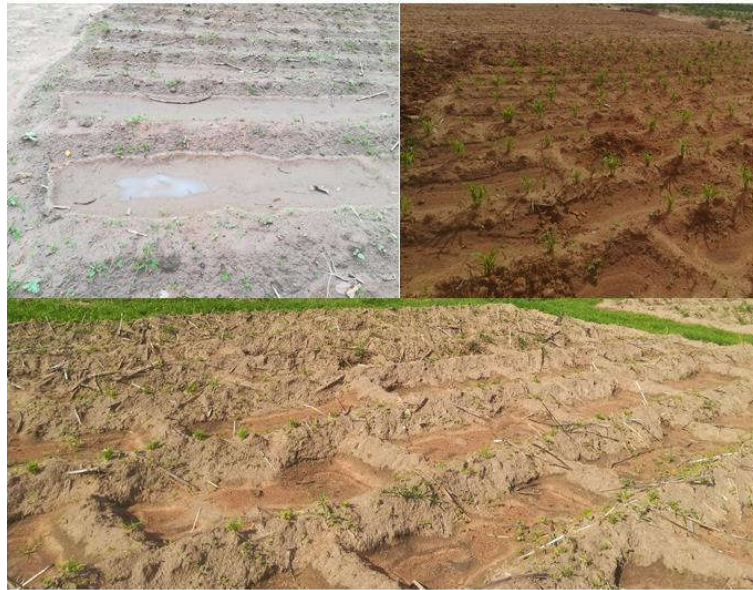
Figure 3. Tied ridges prepared by different farmers in semiarid Dodoma.